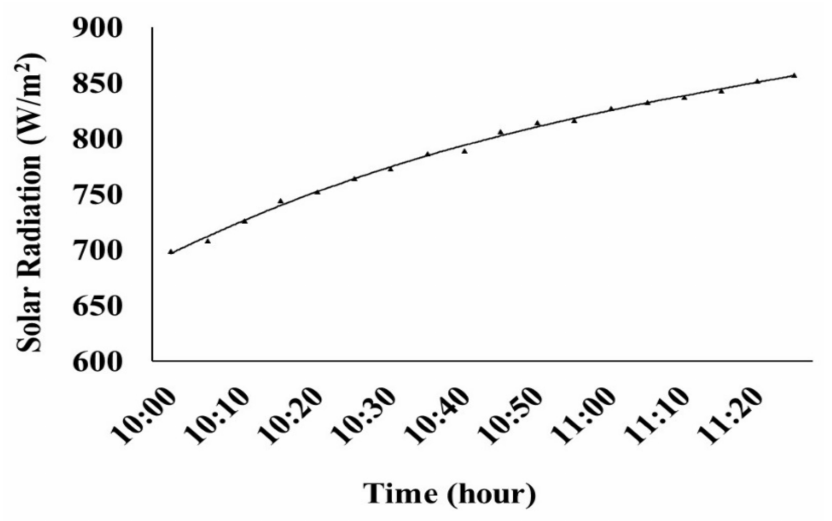
Figure 12. Variation of Solar Radiation with time on 15 April 2022.